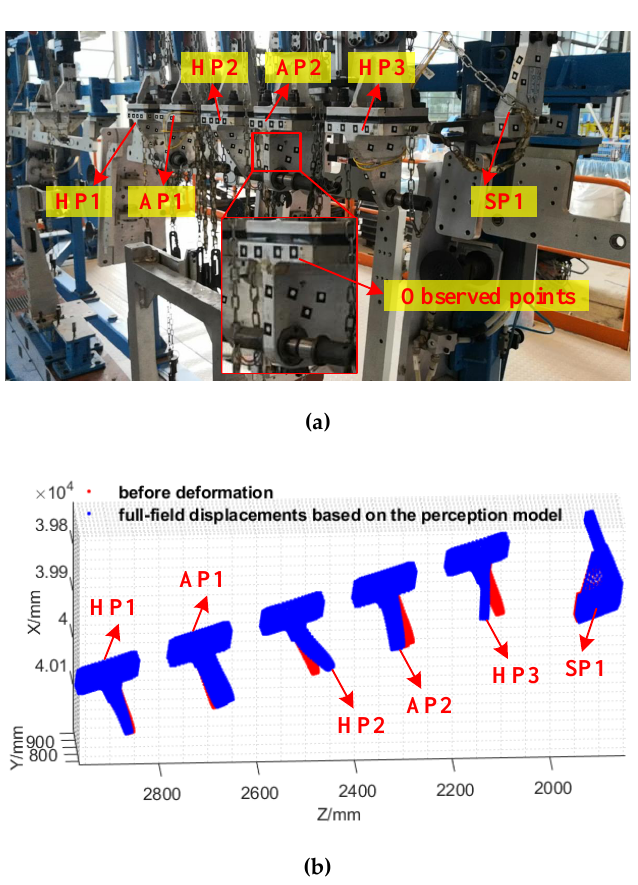
Figure 10. Digital twins for the core positioners in the production site based on the proposed displacement perception method. ( a ) The observed positioners. ( b ) The full-field displacements of the positioners.